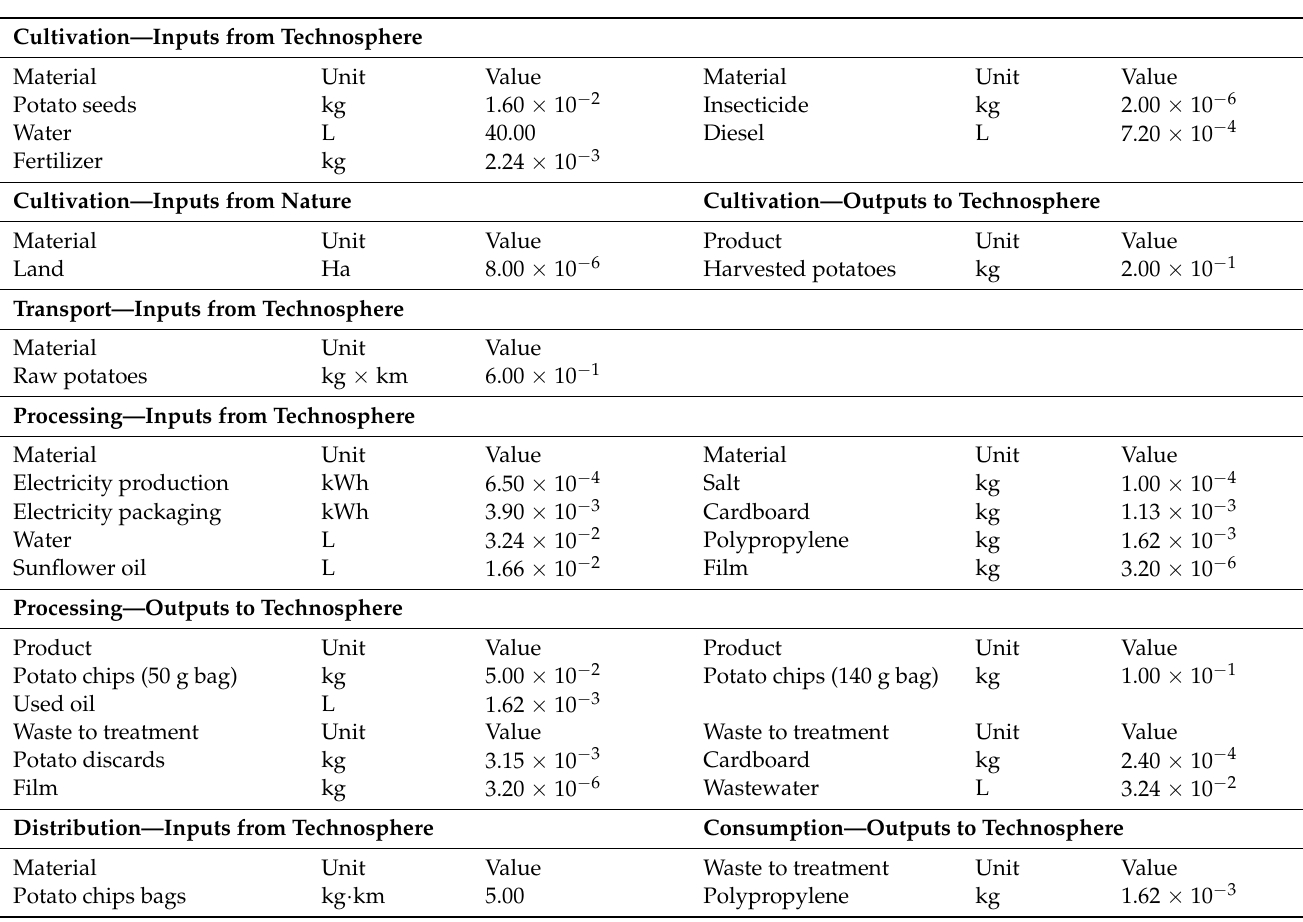
Table 1. LCI for the production of Cantabrian potato chips. All data are provided by FU (50 g bag of potato